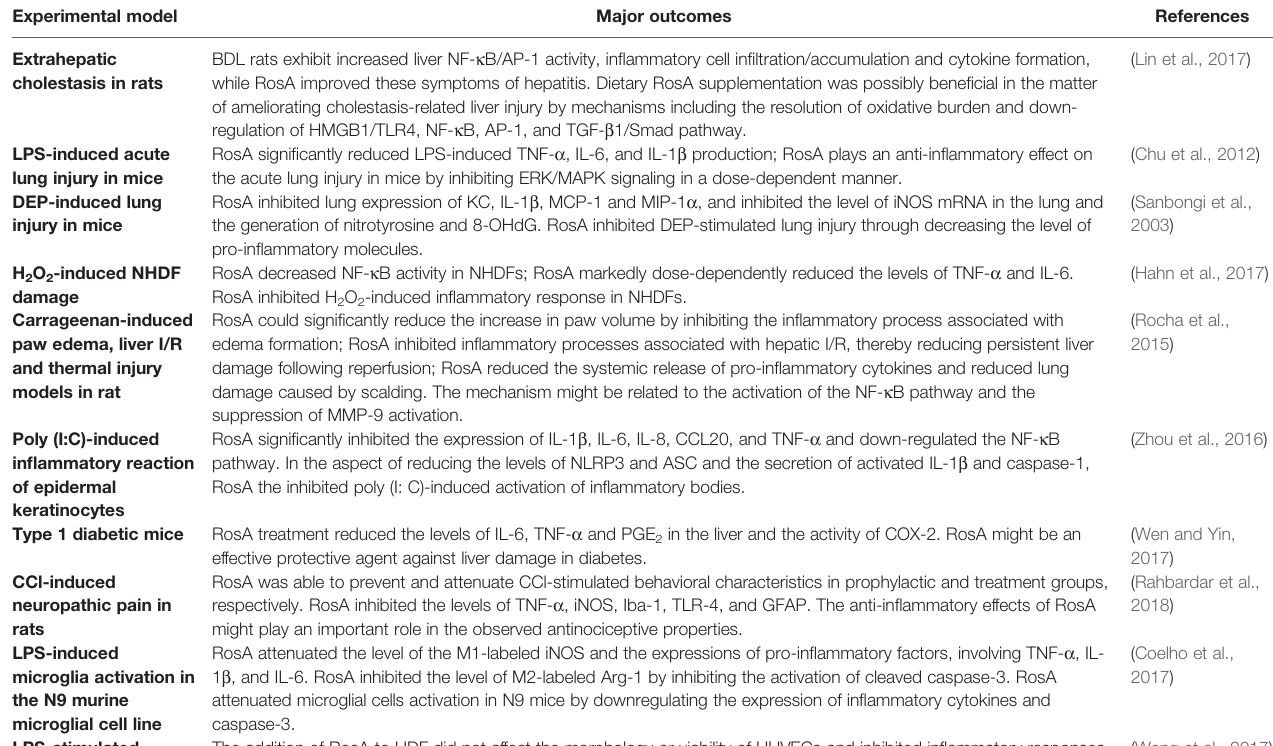
TABLE 1 | The anti-in fl ammatory effect of RosA on different disease models. Experimental